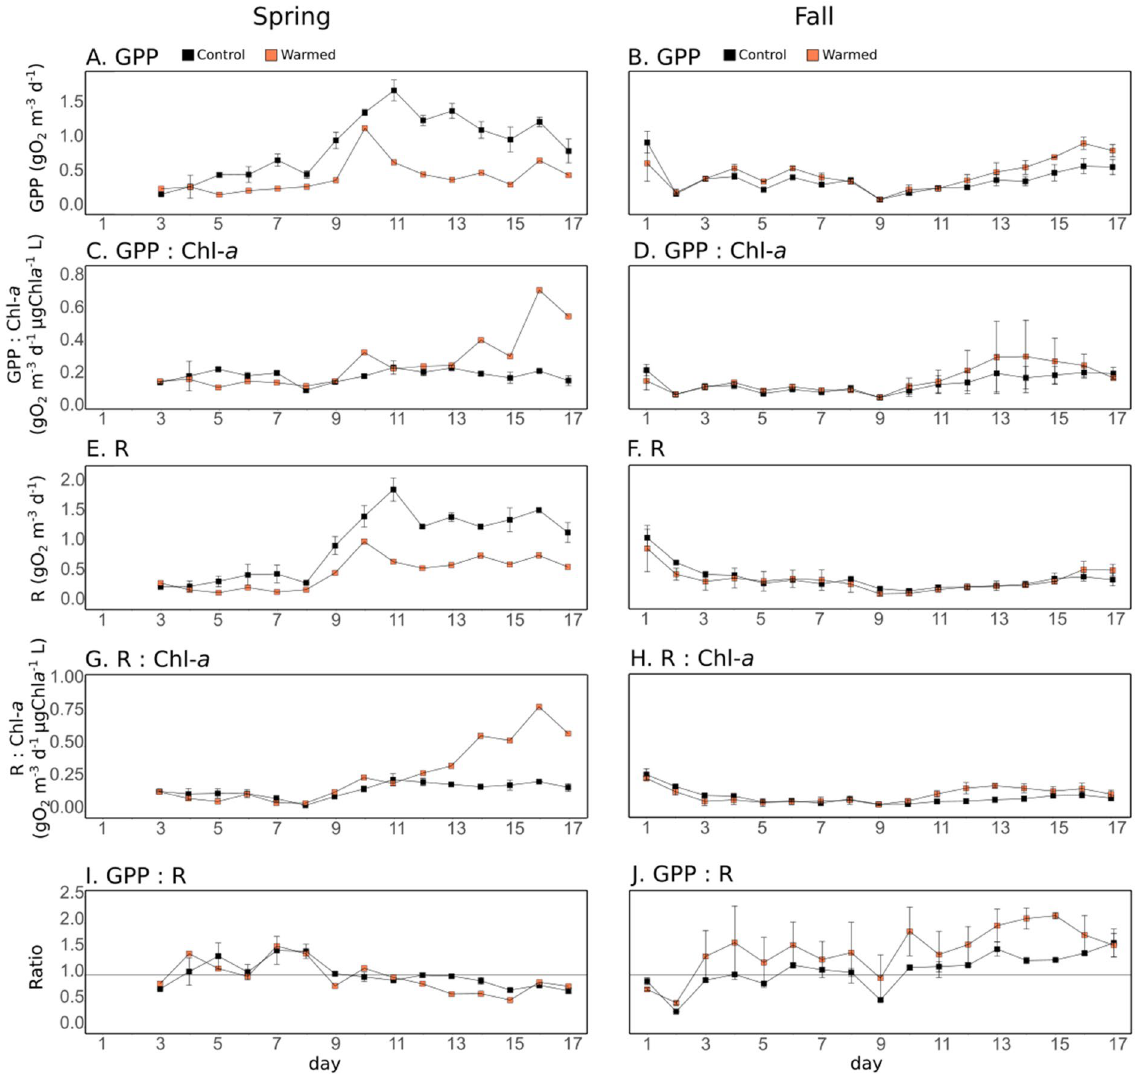
Figure 2. Plankton oxygen metabolism parameters. Gross Primary Production (GPP, A , B ), GPP normalized by the chlorophyll- a fluorescence ( C , D ), Respiration (R, E , F ), R normalized by the chlorophyll- a fluorescence ( G , H ), and GPP:R ratio ( I , J ) in the control (black) and warmed (orange) treatments. Error bars represent range of observation for the two mesocosms per treatment in spring and the standard deviation for the three mesocosms per treatment in fall. In the spring experiment, GPP: Chl- a and R: Chl- a could not be estimated on d1 and